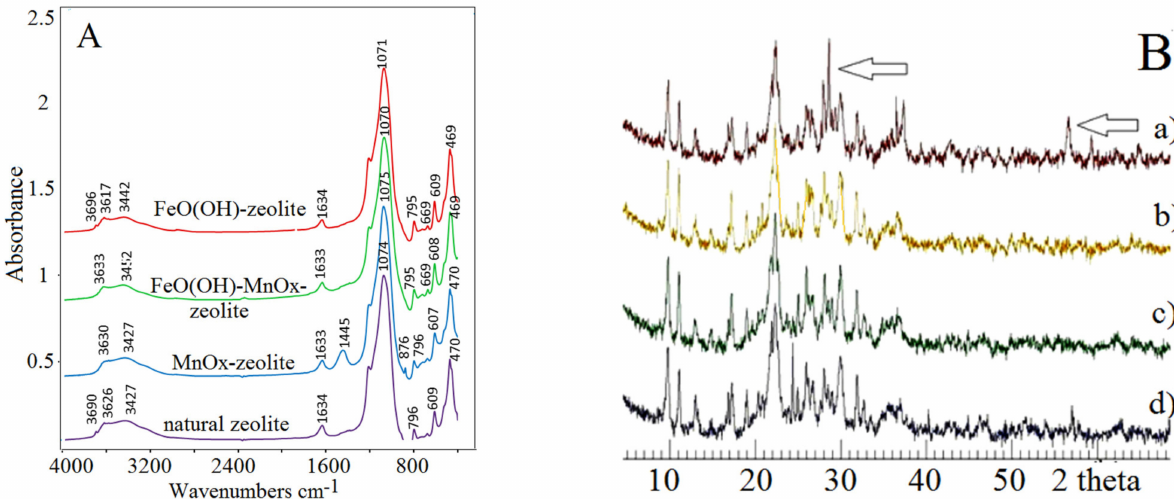
Figure 2. ( A ) FT-IR spectra of samples studied and ( B ) X-ray diffractograms of ( a ) MnOx-zeolite, ( b ) FeO(OH)-MnOx-zeolite, ( c ) FeO(OH)-zeolite, and ( d ) natural zeolite.